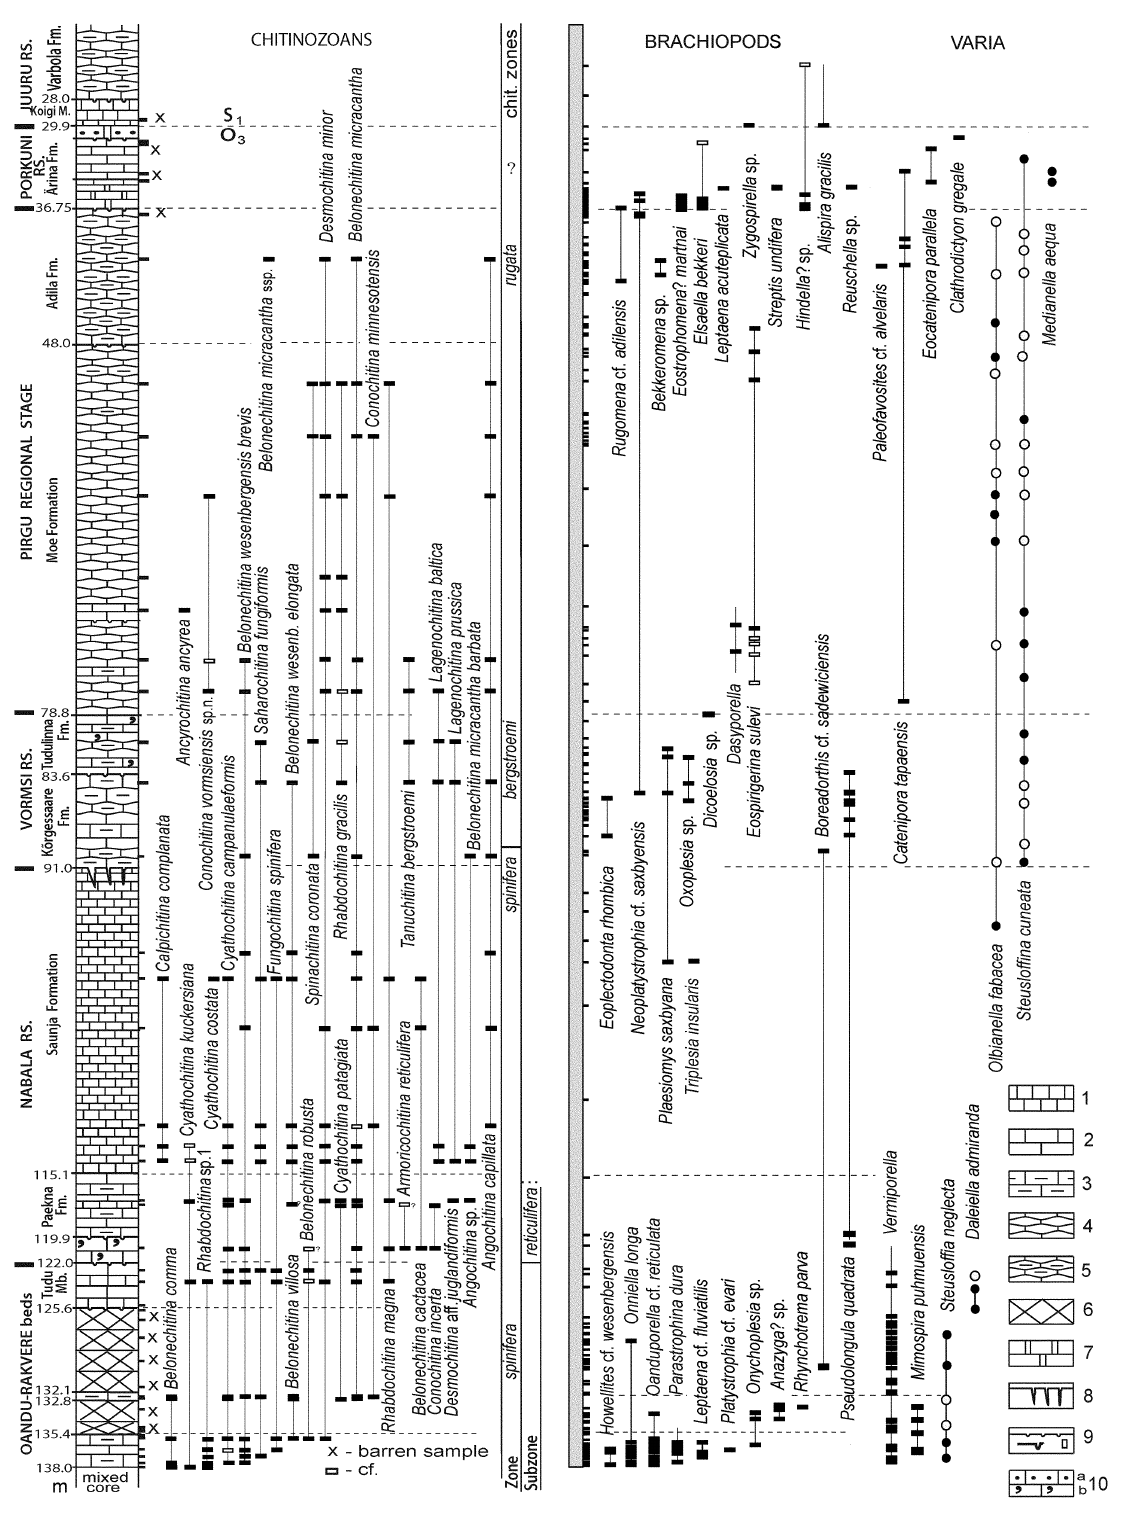
Fig. 3. Lithologies and lithostratigraphy of the Puhmu section with the distribution of fossils and biostratigraphy. Key to lithologies: 1, micritic limestone; 2, wackestone; 3, argillaceous wackestone; 4, nodular wackestone, partly with marl intercalations; 5, nodular wackestone, argillaceous; 6, biohermal limestone; 7, dolostone: 8, palaeokarst surface; 9, discontinuity surface; 10a, sandy dolostone; 10b, glauconite admixture. Black rectangle – full identification, open rectangle – cf. Ostracodes: black circles – common occurrences, open circles – rare occurrences. Ostracode data from Meidla